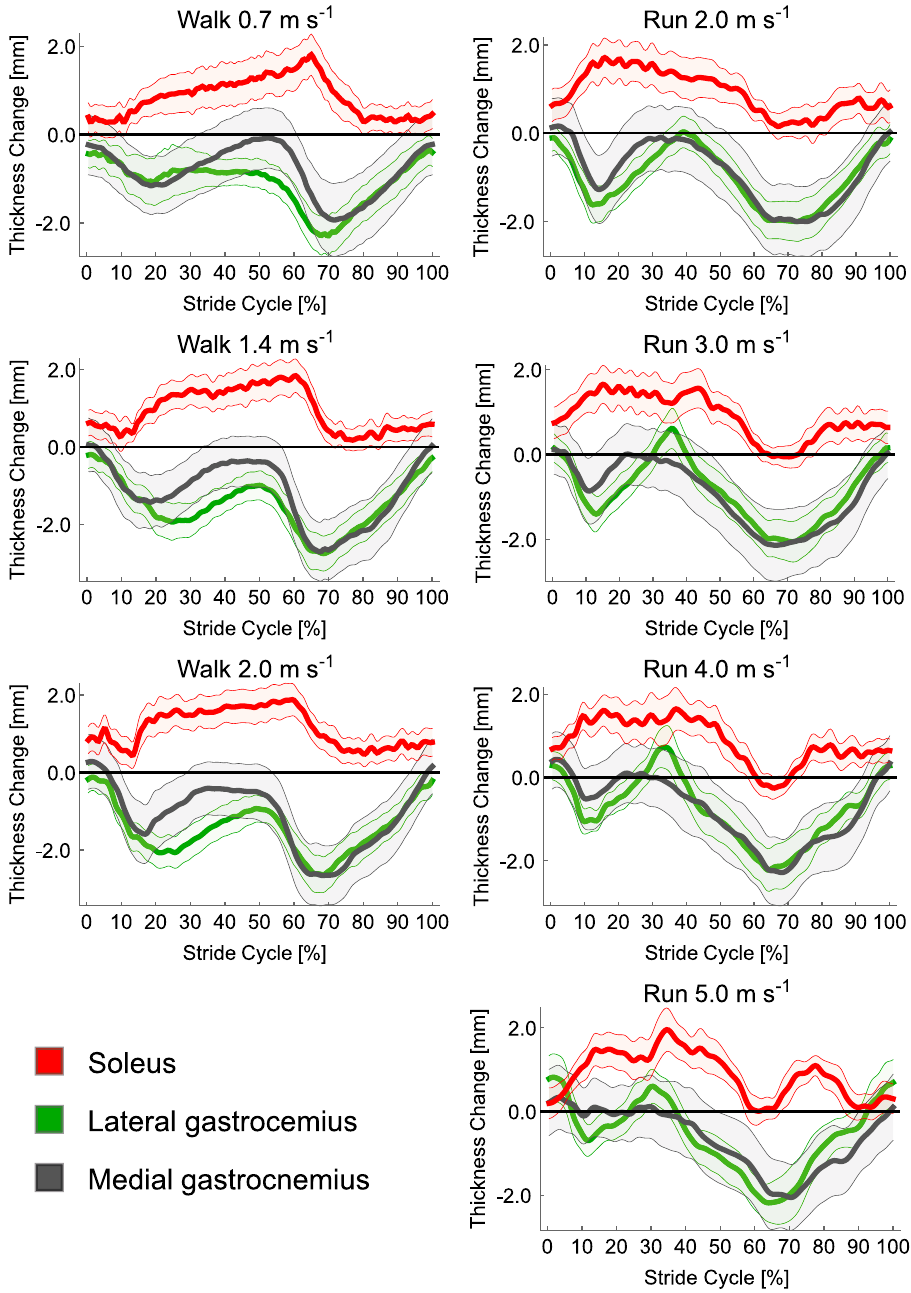
Figure 7. Mean (thick line) and S.E.M. (thin line, colour in-fill) thickness of each muscle (soleus = red; medial gastrocnemius = grey; lateral gastrocnemius = green) as a function of stride cycle for each of the locomotor conditions. SPM paired t-test showed that soleus thickness changes were significantly different to both medial gastrocnemius and lateral gastrocnemius for the whole stride cycle.